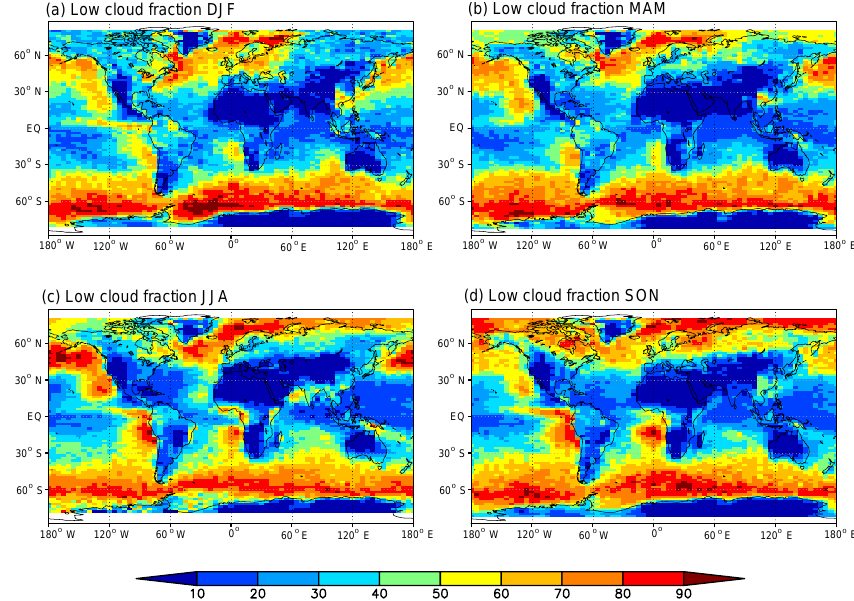
Figure 5. Daytime low-cloud fraction (in %) calculated from profiles not containing middle and high clouds for (a) DJF, (b) MAM, (c) JJA, and (d) SON.